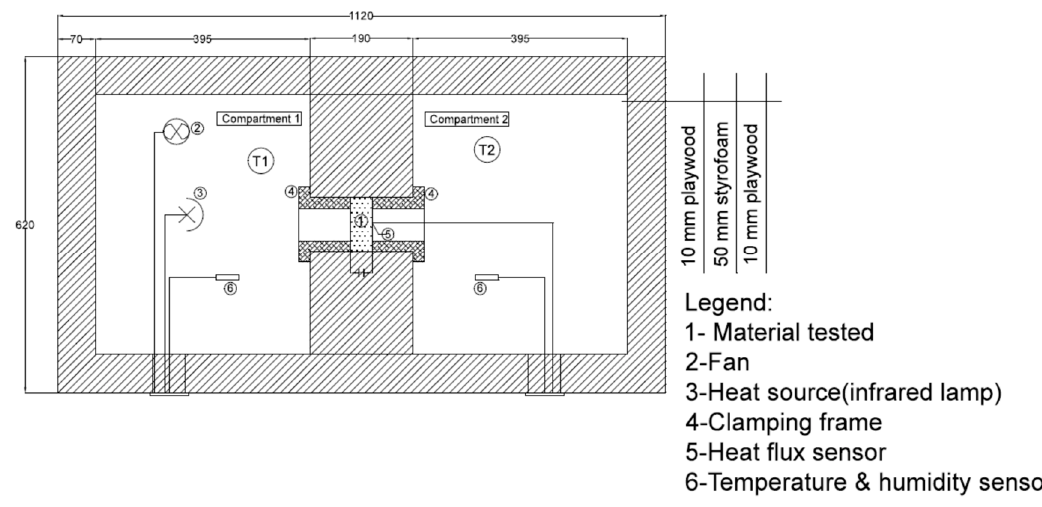
Figure 3. Two-compartment heat box experimental stand in cross section showing its two main compartments.